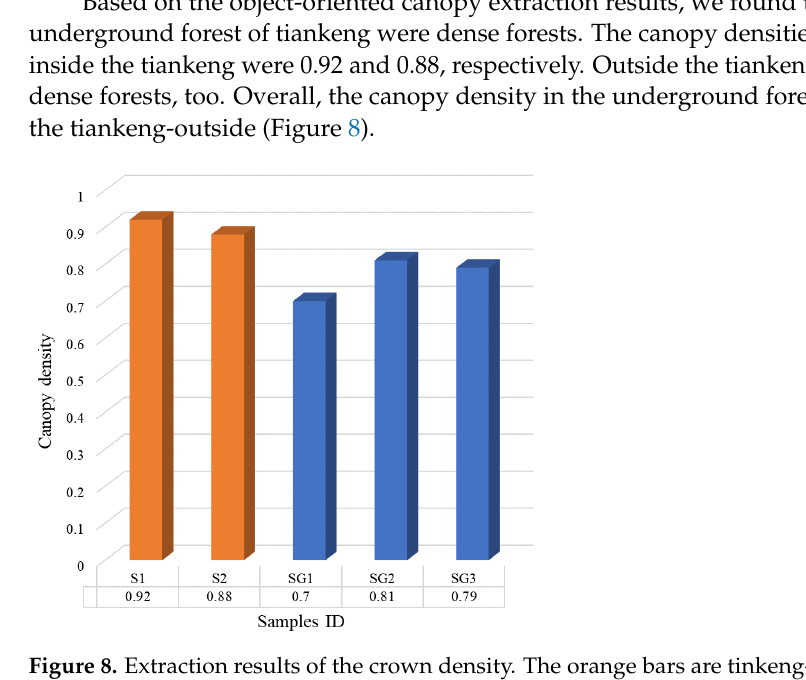
Figure 8. Extraction results of the crown density. The orange bars are tinkeng-inside samples, and the blue ones are tiankeng-outside samples. The values below the sample ID are the canopy density of each sample.